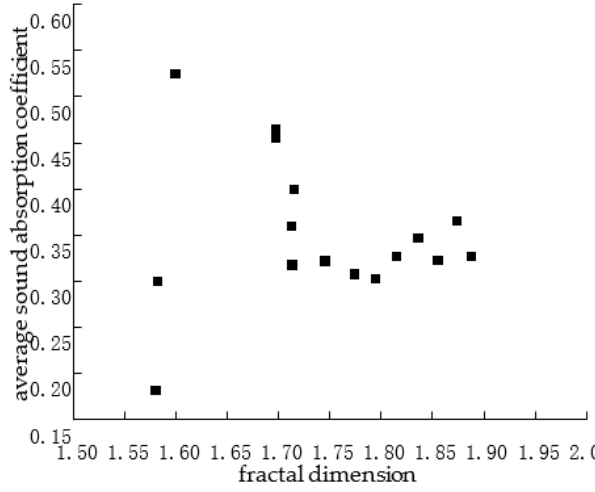
Figure 11. Scatter plot.